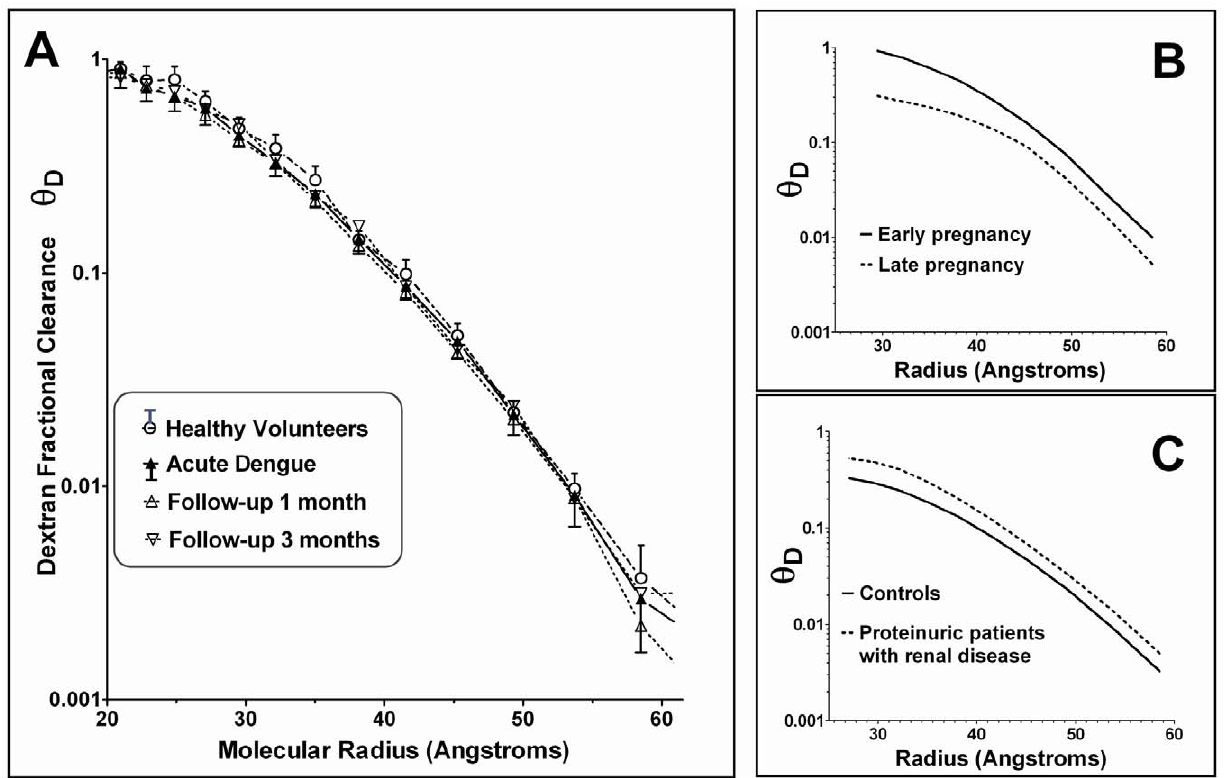
Figure 1. Dextran fractional clearances. Panel A: Mean and standard deviation dextran fractional clearances ( h D ) for dengue patients during the acute phase (n=15), and at 1 month (n=15) and 3 months (n=14) following recovery, compared with healthy volunteers (n=16). For reasons of clarity the standard deviation markers are only presented for the acute dengue results, and for the healthy volunteers. Panels B and C: For comparison, these panels depict schematic examples of typical patterns seen when clearances are reduced, for example during pregnancy, or increased, for example in patients with renal disorders.